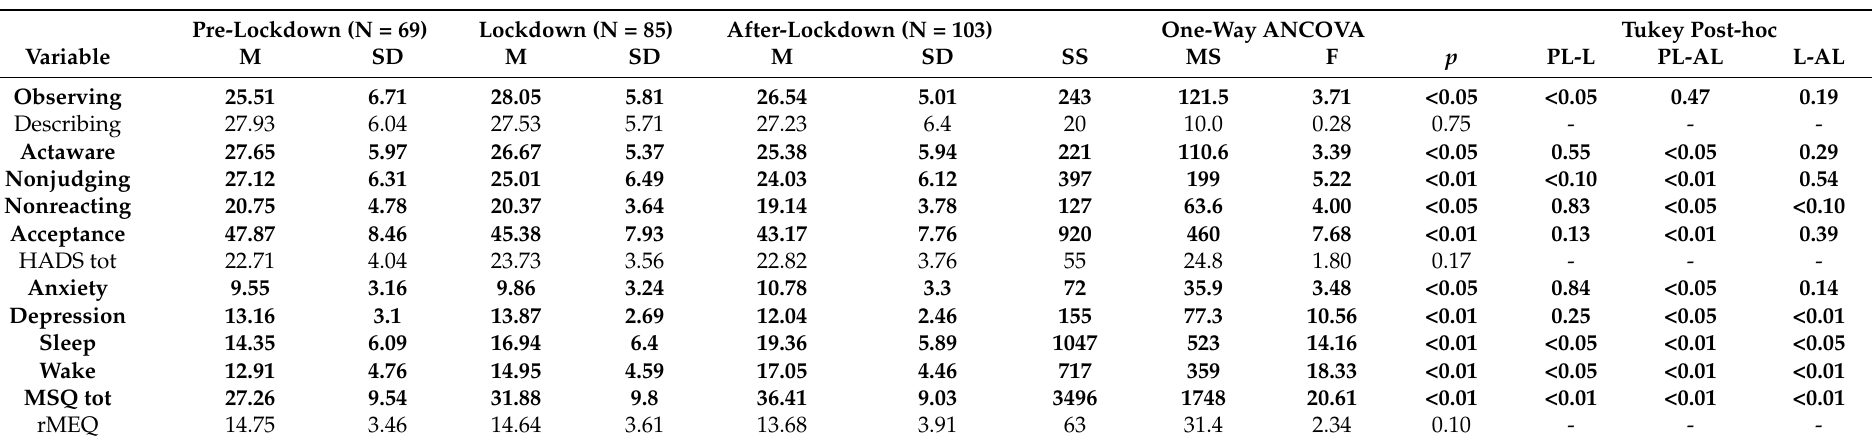
Table 1. Mean, standard deviation, ANCOVA statistics and Tukey post-hoc comparisons for the psychological variables measured in the three phases. Significant results are shown in bold.